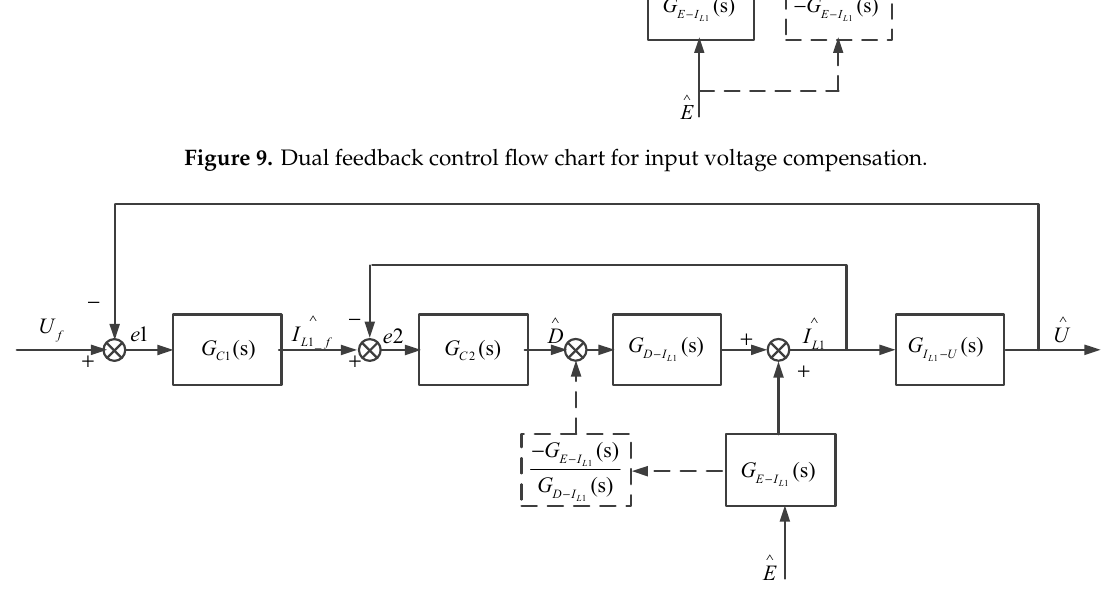
Figure 10. Feedforward-double feedback control flow chart.